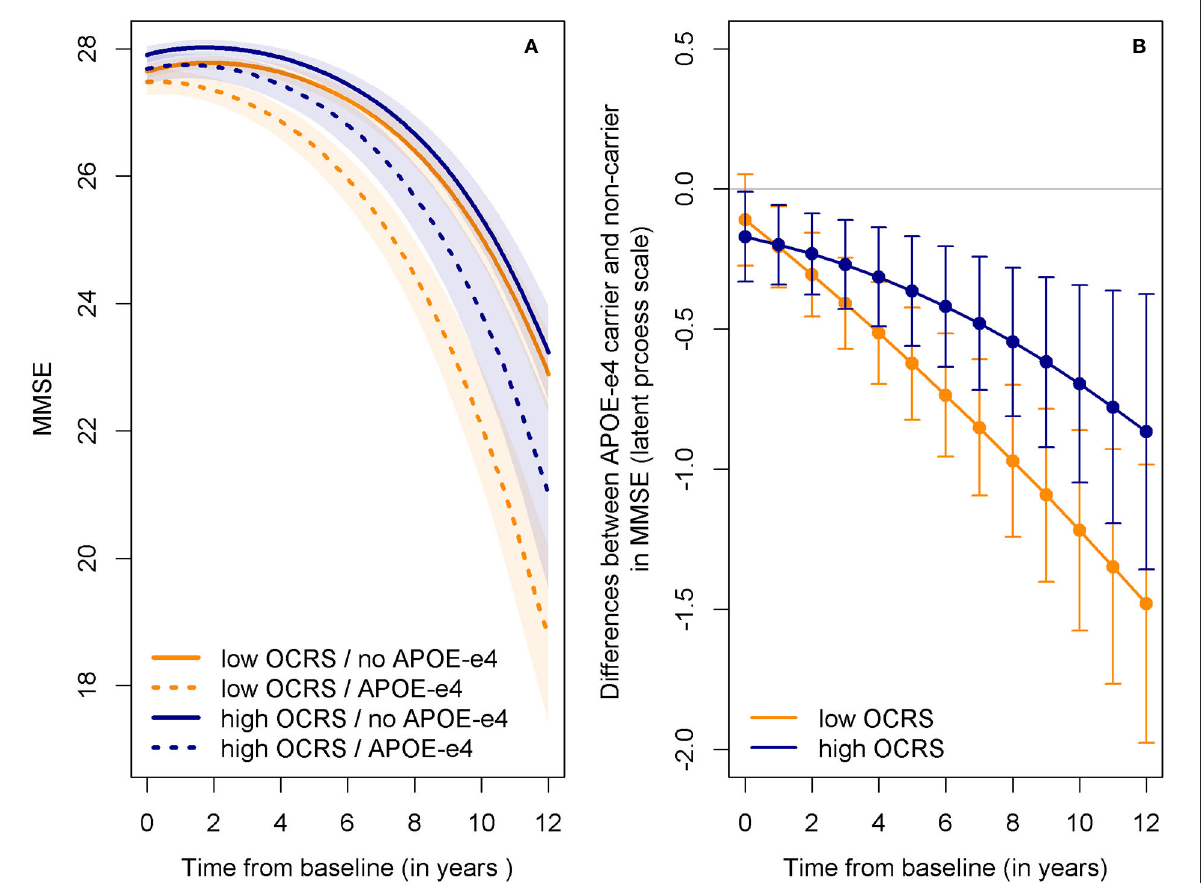
FIGURE4 Predicted trajectories of cognitive decline in AgeCoDe depending on OCRS and APOE- ε 4. (A) Predicted trajectories in MMSE for APOE- ε 4 carrier and non-carrier with either low (25th percentile) or high (75th percentile) OCRS levels. Shaded areas indicate 95% confidence intervals. While APOE- ε 4 is generally associated with a stronger cognitive decline (steeper slope for dotted compared to straight lines), this difference is larger in individuals with low OCRS (orange lines) compared to high OCRS (blue lines). (B) Differences in MMSE between APOE- ε carrier and non-carrier at different time points for individuals with either low (25th percentile) or high (75th percentile) OCRS levels. Bars indicate 95% confidence intervals. Differences are presented on the scale of the latent variable in the latent process mixed models (Proust-Lima et al., 2011), not on the scale of the observed variable (i.e., the MMSE). Differences are generally lower (i.e., closer to zero) for individuals with high (blue line) as compared to low (orange line) OCRS values. APOE-e4, apolipoprotein E ε 4 allele; MMSE, Mini-Mental-State-Examination; OCRS, occupational cognitive requirement